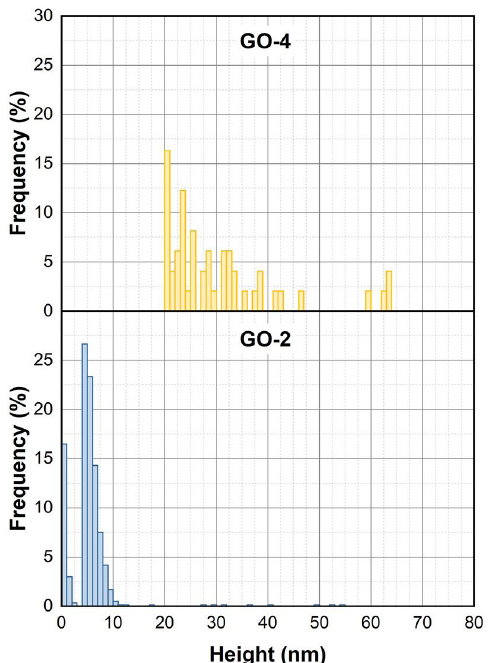
Figure 7. AFM particles height distribution for GO-2 and